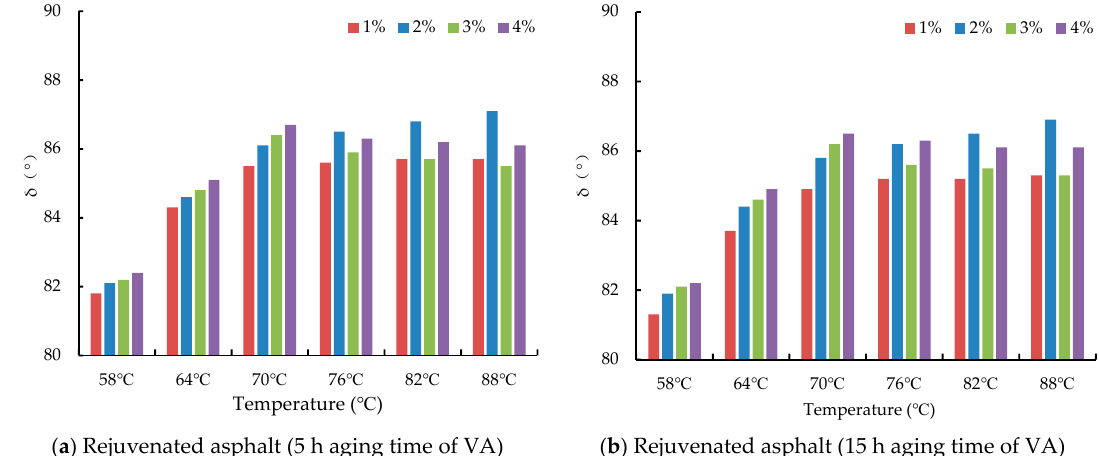
Figure 11. Influences of WEO on phase angel of rejuvenated asphalt (different aging time of VA).